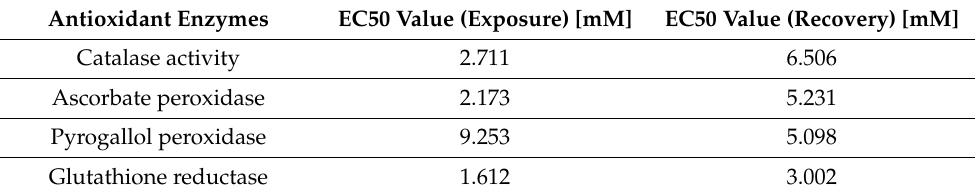
Figure 4. Catalase activity ( A ), ascorbate peroxidase ( B ), pyrogallol peroxidase ( C ), glutathione reductase ( D ) in Lemna minor subjected to tetracycline (exposure) and in the recovery phase (R) (resumed growth after 7 days of culture in an antibiotic-free medium). Means denoted with different letters are significantly different ( p ≤ 0.05) across the described groups: average ± standard deviation. Table 3. EC50 values for catalase activity (CAT), ascorbate peroxidase (APX), pyrogallol peroxidase (PDX), glutathione reductase (GR) in Lemna minor subjected to tetracycline (exposure) and in the recovery (R) (resumed growth after 7 days of culture in antibiotic